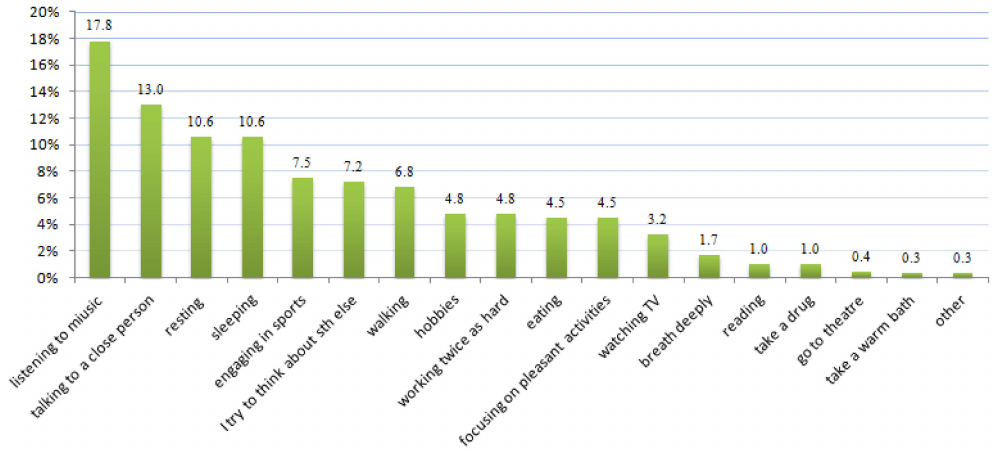
Figure 4. How do you cope with